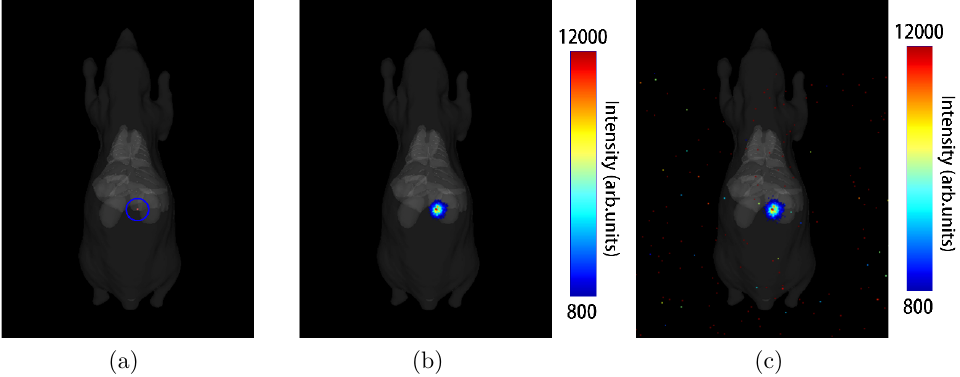
Fig. 2. Numerical Simulation of CLI image: (a) the digital mouse and CL source location, which is the red point in the blue circle; (b) simulated CLI image and (c) simulated CLI image after the addition of